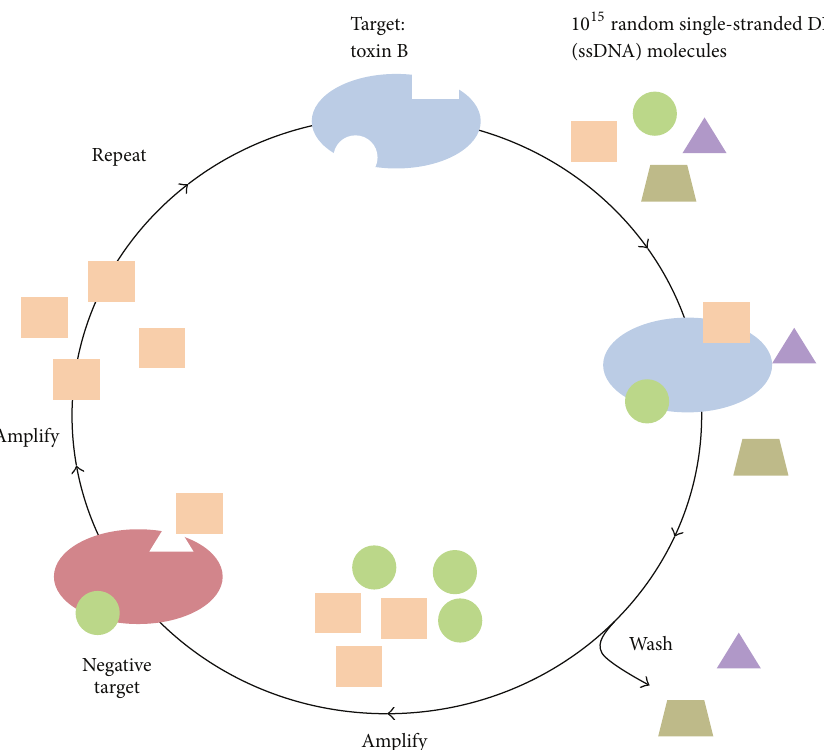
Figure 1: Illustration of the SELEX process. The SELEX process begins with 10 15 ssDNA molecules and incubation with the target toxin B. Those that bind to toxin B are amplified and subsequently incubated with negative targets. Those that do not bind to negative targets are retained and amplified, thus completing one round of in vitro